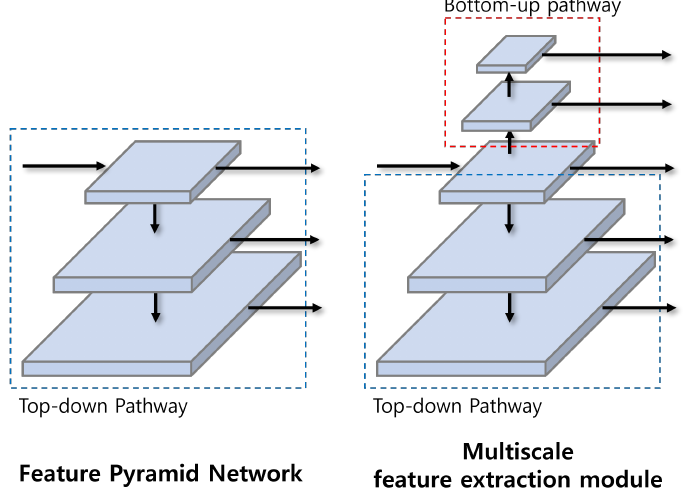
Figure 3. Multiscale feature extraction module and feature pyramid